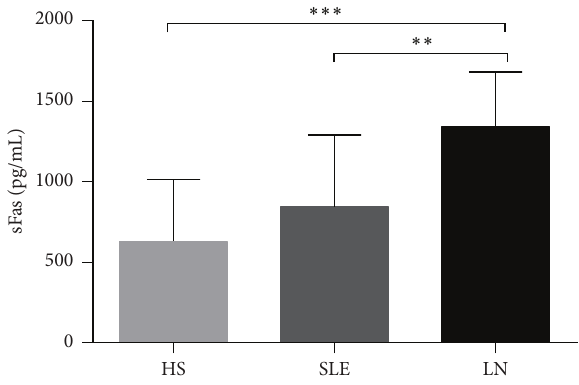
Figure 4: The sFas level in the serum of SLE and LN patients and HS. The concentration of sFas was increased in patients with LN. ∗∗ 𝑃 < 0.01 ; ∗∗∗ 𝑃 < 001 .